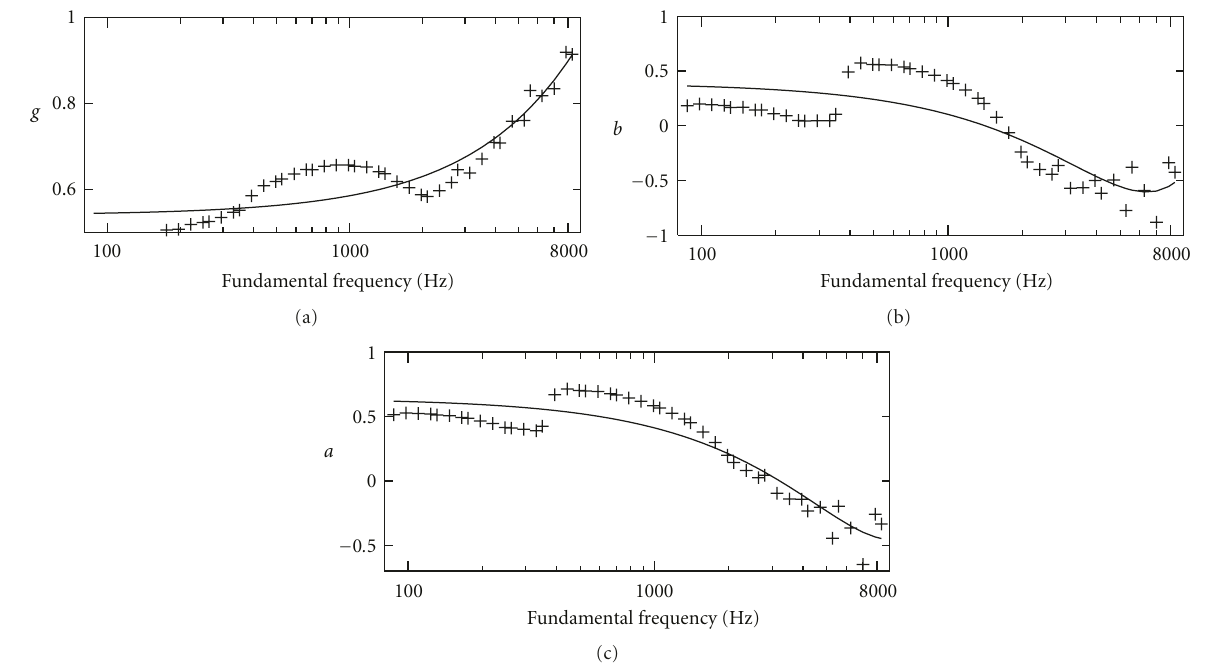
Figure 8: First-order filter parameter estimates (plus signs) for the ideally bandlimited oscillator: (a) the gain factor g , (b) the filter zero b , and (c) the filter pole a . The solid lines represent the polynomial approximations of the filter